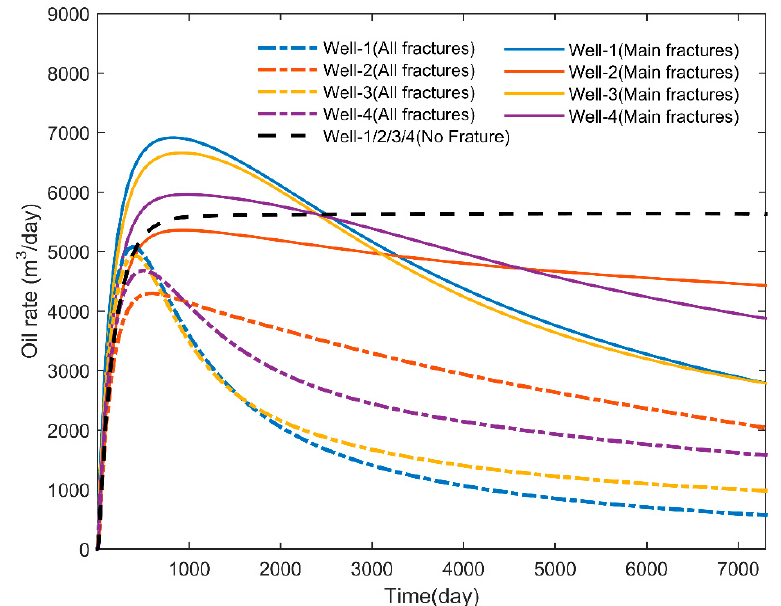
Figure 11. Comparison of oil production rate for Case 4.